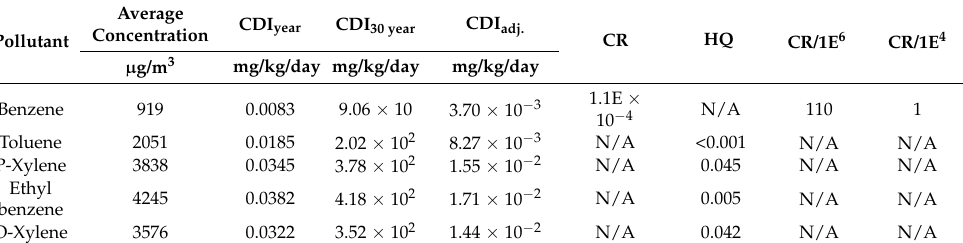
Table 6. Carcinogenic and non-carcinogenic risks for adult